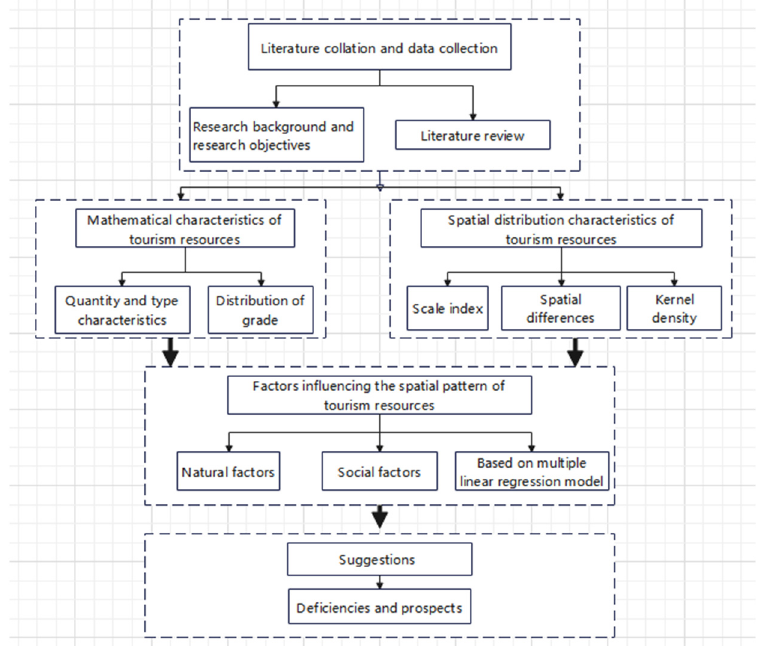
Figure 1. Research framework.